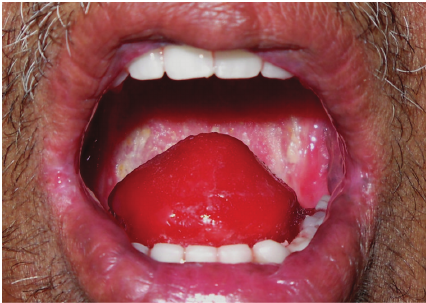
Figure 5: Wax up trial of tongue prosthesis in the patient’s mouth.